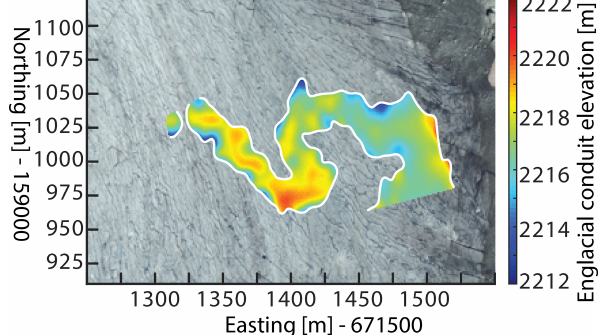
Figure 10. Elevation above mean sea level from the top of the englacial conduit network in August